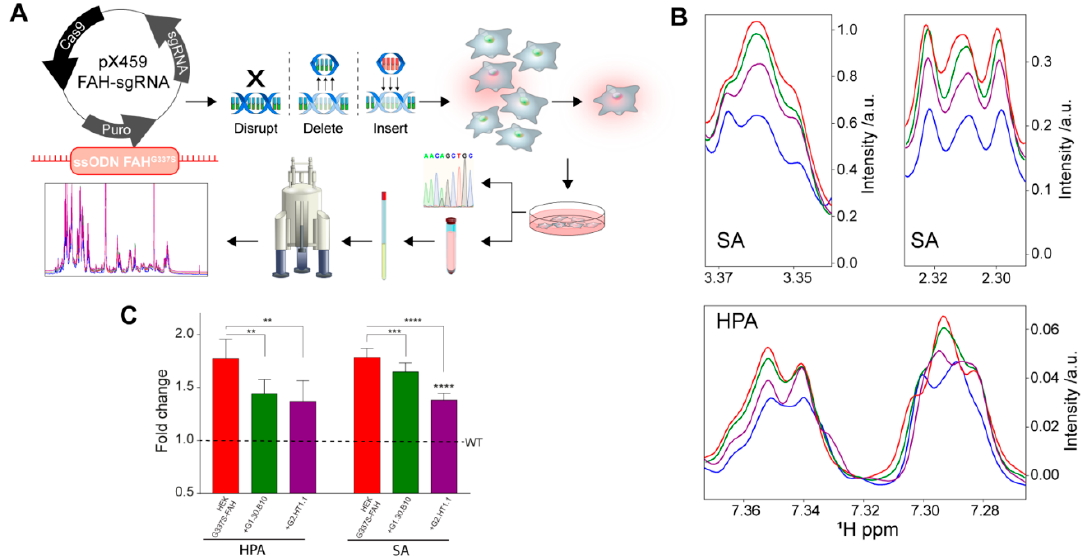
Figure 4. A cellular model of HT1. ( A ) Scheme for the generation of an HT1 cellular model, based on the genomic modification (G337S in the fah gene) using the CRISPR/Cas9 technology. ( B ) Regions of the 1 H-NMR spectrum of the extracellular media in contact with: WT-HEK cells (blue), G337S-FAH-HEK cells (red), or the latter but incubated with G1.30.B10 (green) or G2.HT1.1 (purple). The cellular model adequately reflects the phenotype of HT1 patients since it accumulates succinylacetone (SA) and hydroxyphenylpyruvate (HPA), among other metabolites. ( C ) Bar plot with the changes in SA and HPA, quantified from the 1H-NMR spectrum. P-values of < 0.01, 0.001 and 0.0001 are represented by **, *** and **** respectively.